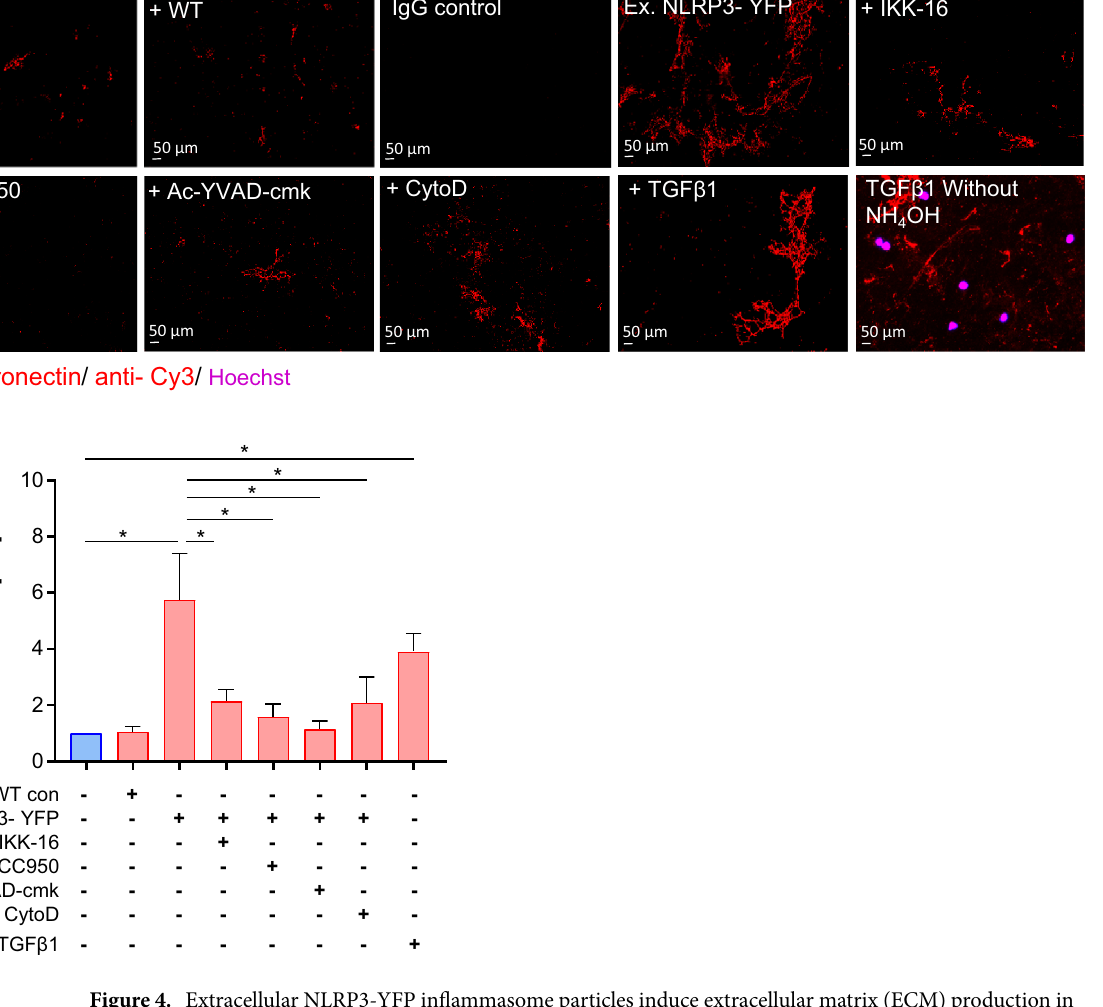
Figure 4. Extracellular NLRP3-YFP inflammasome particles induce extracellular matrix (ECM) production in HCASMC that can be reduced by different inhibitors. (A) Immunofluorescent staining of cell-free ECM protein fibronectin (red) produced by HCASMC after treatment with extracellular NLRP3-YFP inflammasomes (3:1 particles/ cell) for 24 h (N = 5). ECM production was reduced when cells were co-stimulated with inhibitors such as IKK-16 (2 µM), Ac-YVAD-cmk (25 µg/ml), MCC950 (1 µM) for 24 h or pre-incubation with CytoD (2.5 µg/ml) for 30 min. Antibody against fibronectin (1 µg/ml, Santa Cruz) or IgG mouse isotype control as well as anti-rabbit anti-mouse Cy3 antibody (1:1000, Dianova) were used (scale bar: 50 µm). Ammonium hydroxide (NH 4 OH) was used to remove cells and only stain extracellular fibronectin. Negative Hoechst (nucleus) staining showed successful removal of cells. TGFβ1 (48 h) was used as positive control. ( B ) Five random selected fields were used for ImageJ analysis and the positive stained area (% of area) from images with same magnification was calculated. Data were normalized on the untreated control which was set at 1. Data are expressed as mean ± SEM and differences between the groups were compared using One-way ANOVA and Sidak´s post-hoc test (*p <